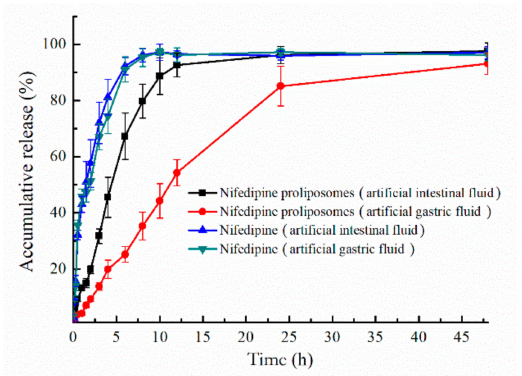
Figure 4. Accumulative release of nifedipine. Artificial intestinal fluid and gastric fluid were used as medium to compare the release of nifedipine and nifedipine proliposomes.